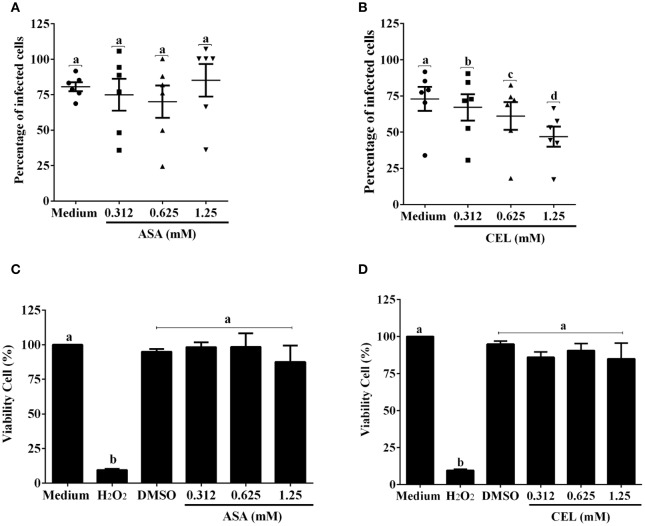
Inhibition of ciclooxigenase-2 impairs T. cruzi entry into DC-PBMC Percentage of infected cells from the interaction process between DC-PBMC treated for 1 hour with ASA (A) or CEL (B) [0.312, 0.625, and 1.25 μM] and exposed to 5:1 trypomastigotes of T. cruzi (Y strain) during 18 h. After DC-PBMC were fixed with methanol and stained with Giemsa stain. Quantification was carried out under a light microscope where the number of intracellular parasites was counted in a total of least 200 cells. MTT assay to measure cell viability in DC-PBMC after treatment with ASA (C) or CEL (D). H2O2 (1,000 μM) was used as positive control. Values are the mean ± standard error of two experiments. DMSO, Dimethyl sulfoxide 0.05%. Results are the mean ± standard error for duplicate determinations, with six blood donors in each experiment. Means not sharing letter are significantly different (P < 0.05, one-way ANOVA with Tukey's post-test).